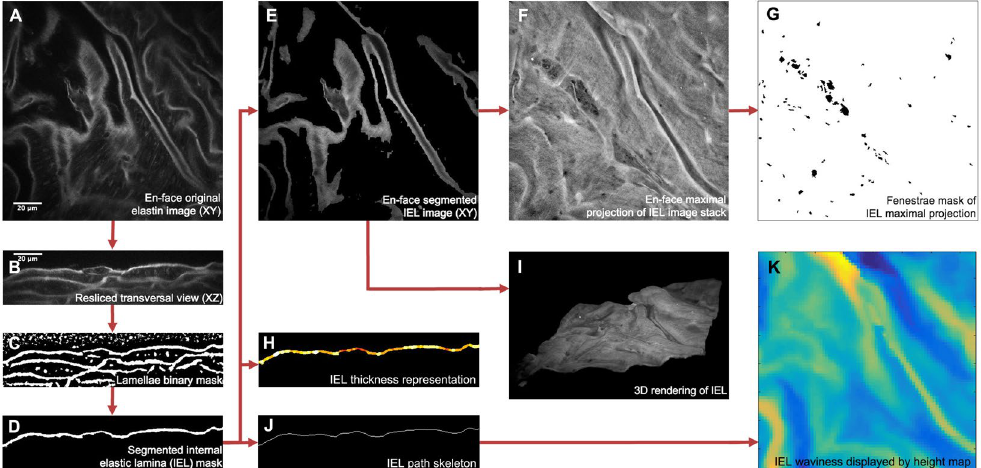
Figure 2. Image processing protocol to obtain en-face segmented elastic laminae and subsequent quantitative analysis. ( A ) Representative image of an acquired original en-face TPEF stack. Elastin TPEF and background cell autofluorescence signals are visualized in grey scale. ( B ) Representative image of the resliced original stack to transverse view. ( C ) Representative image of the binary mask stack that was subsequently obtained. Elastin signal and some background spots are automatically marked in white, the rest of the tissue is marked in black. ( D ) Representative image of segmented individual lamina mask stack. In this case, only the IEL mask was selected. ( E ) Representative image of the resulting en-face IEL stack. ( F ) En-face maximal projection comprised of all images within the IEL stack. ( G ) Binary mask of all fenestrae seen at the maximal projection ( F ). ( H ) Representative image of thickness display stack. Highest thickness is marked by white colour. ( I ) 3D rendering of the lamella obtained from the IEL stack. ( J ) Representative image of lamella skeleton image stack. ( K ) Height map showing global lamella waviness. Yellow denotes low and dark blue high heights. Scale bar, 20 µ